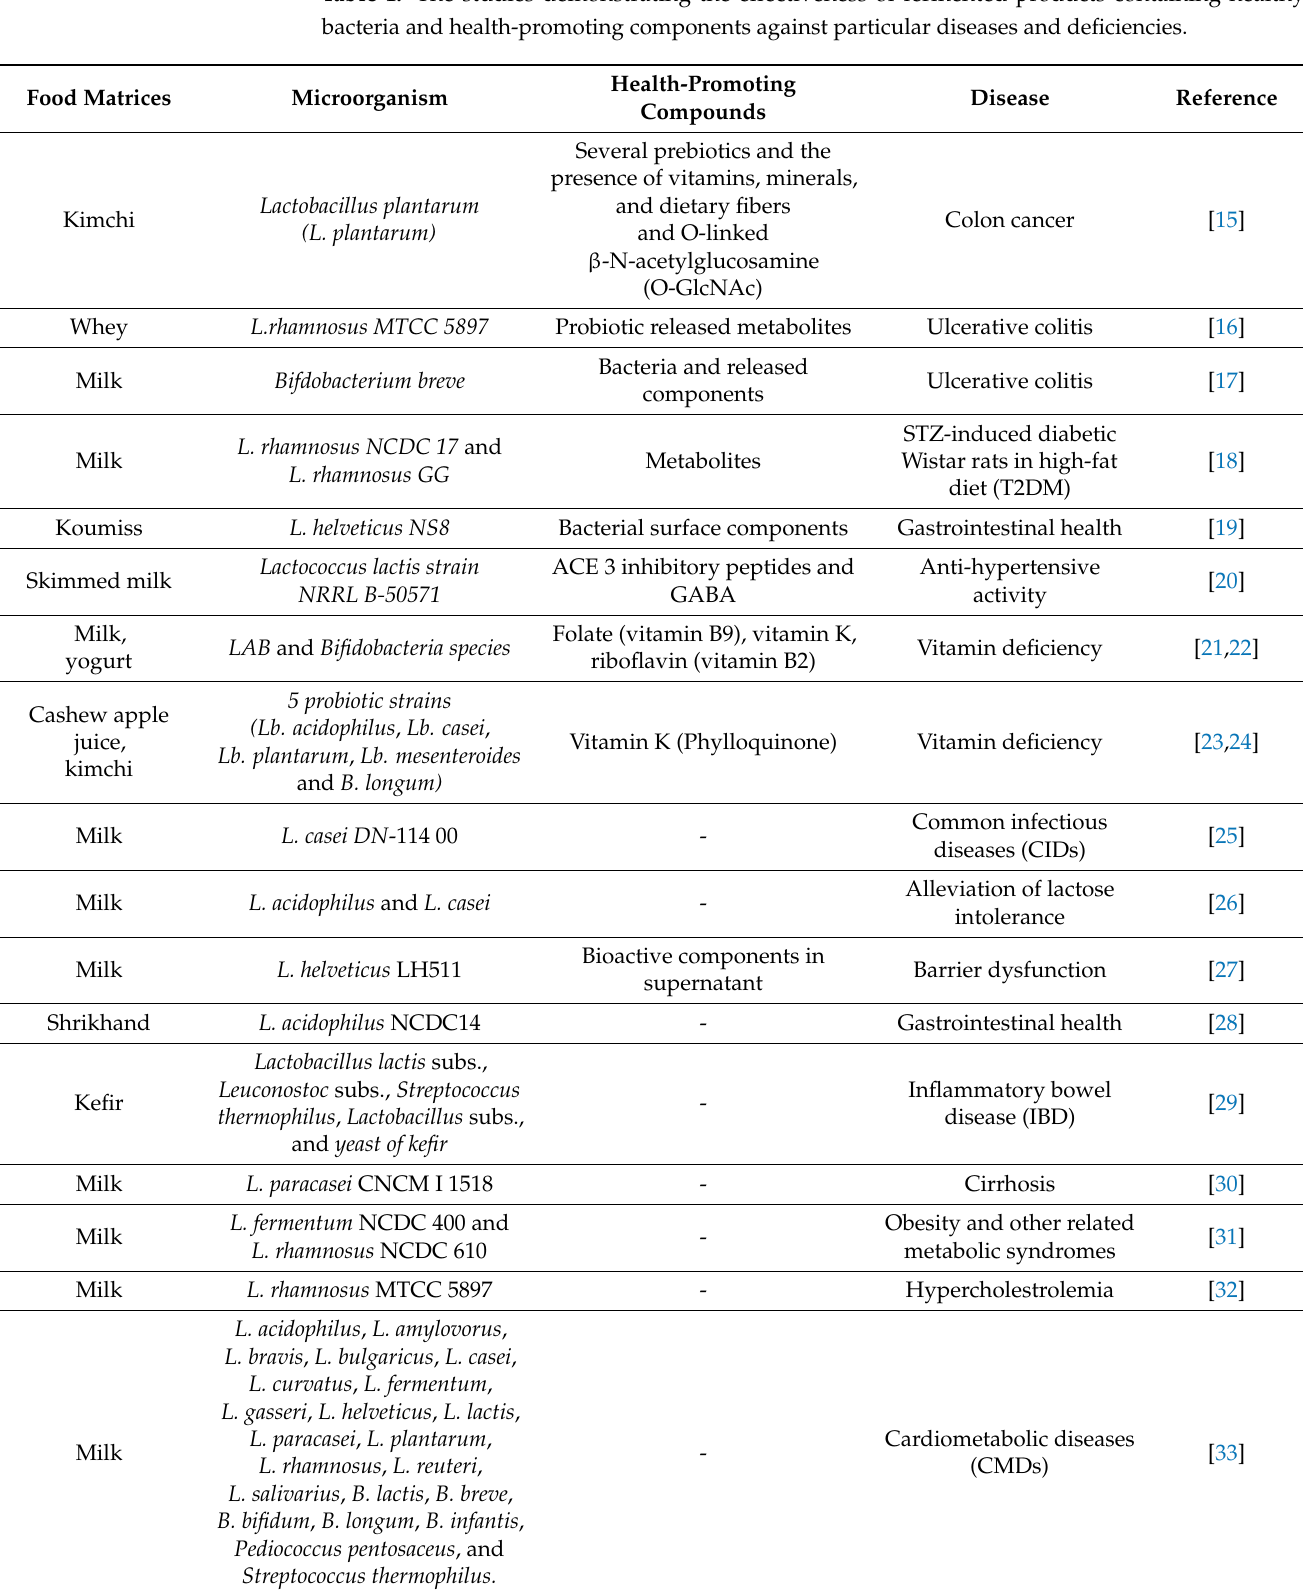
Table 1. The studies demonstrating the effectiveness of fermented products containing healthy bacteria and health-promoting components against particular diseases and